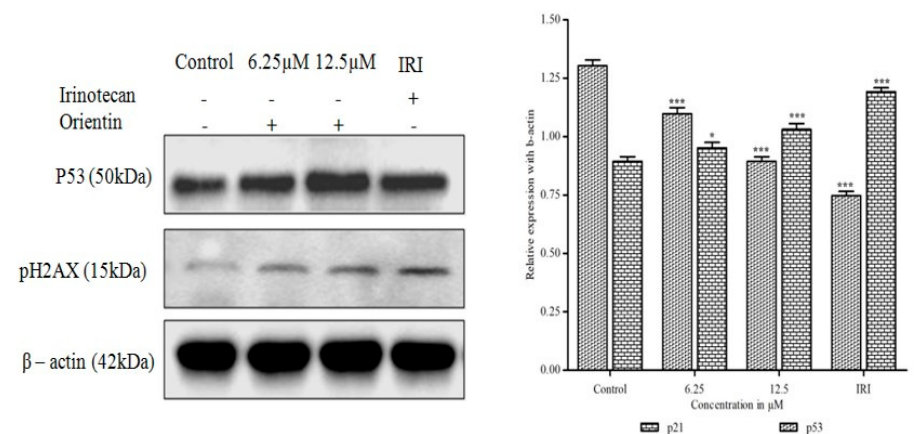
Figure 11. E ff ect of orientin on p53 and DNA damage. HT29 cells have shown a decrease in the expression of p53 and increase in the expression of pH2AX protein involved in DNA repair. β -actin was used as an internal control. Quantitative expression of proteins has shown after normalization to β -actin. Values are represented as the mean ± SD of three independent experiments (* p < 0.05, ** p < 0.01 and *** p < 0.001 vs. control).